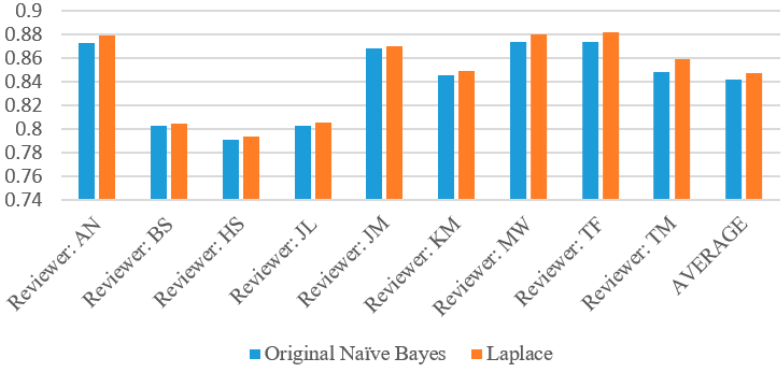
Figure 5. Accuracy for each reviewer with both original Naïve Bayes and Laplace.